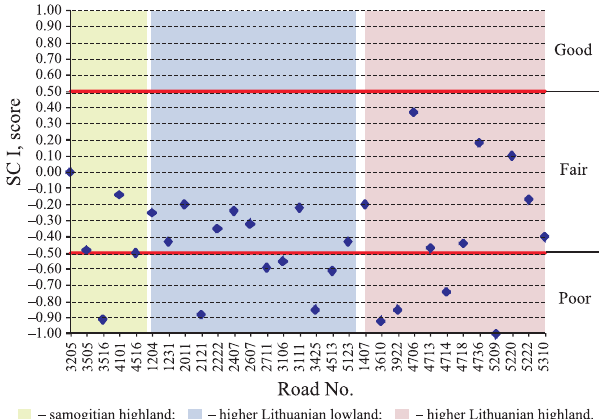
Fig. 1. Design level of the study road elements according to the SC I